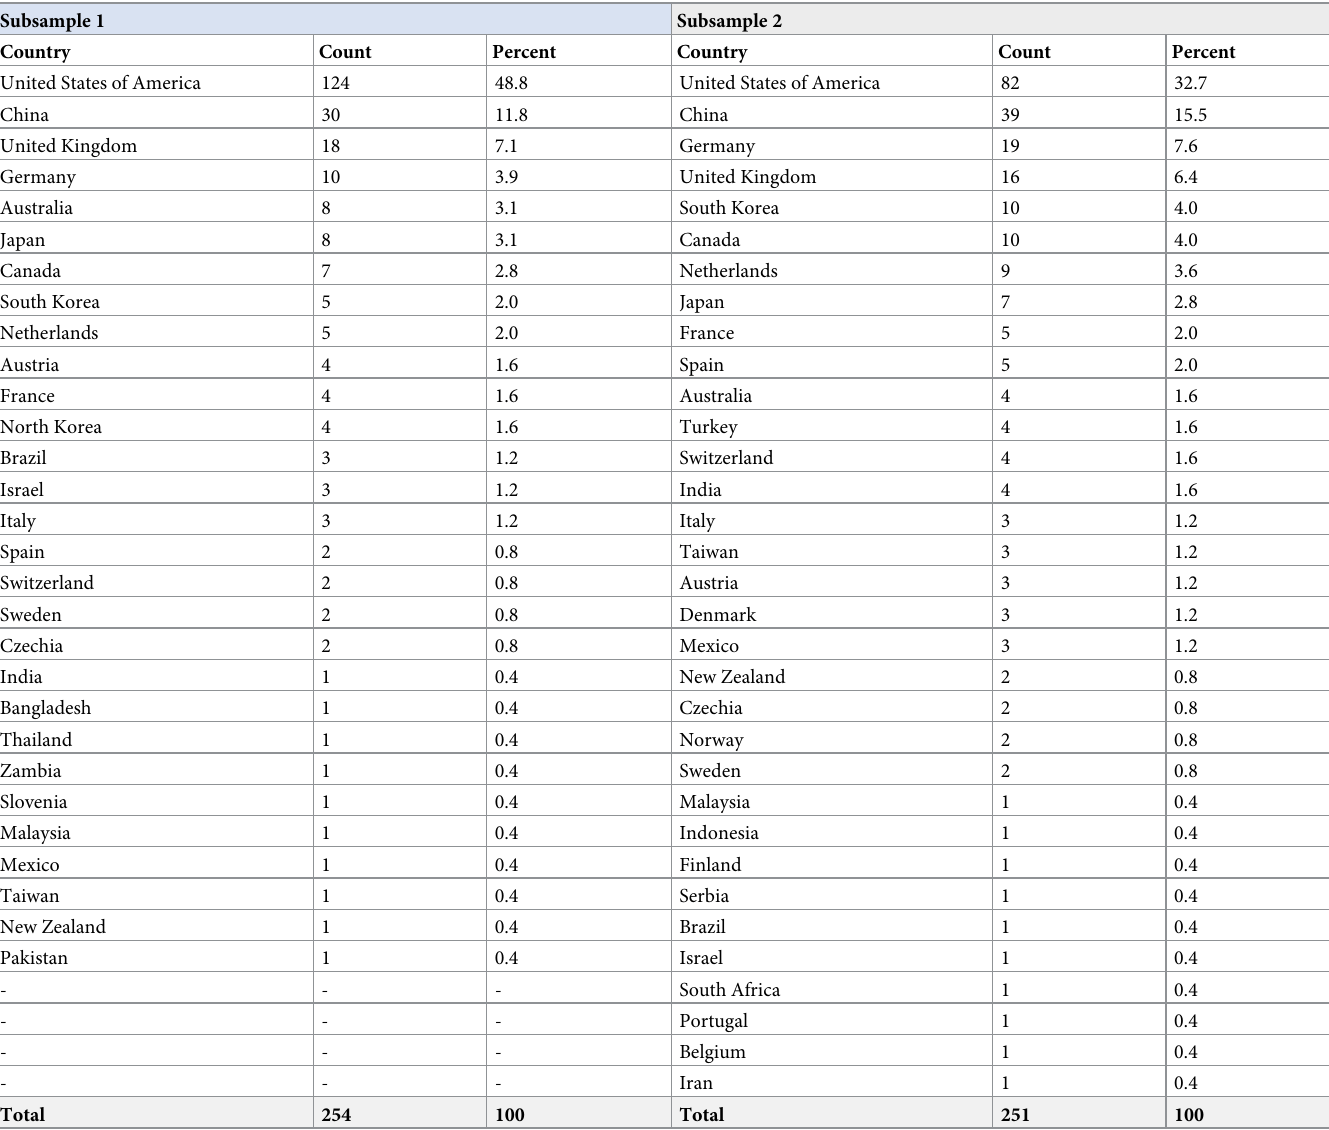
Table 1. Tagged subsamples of distribution of database nationality in AI in